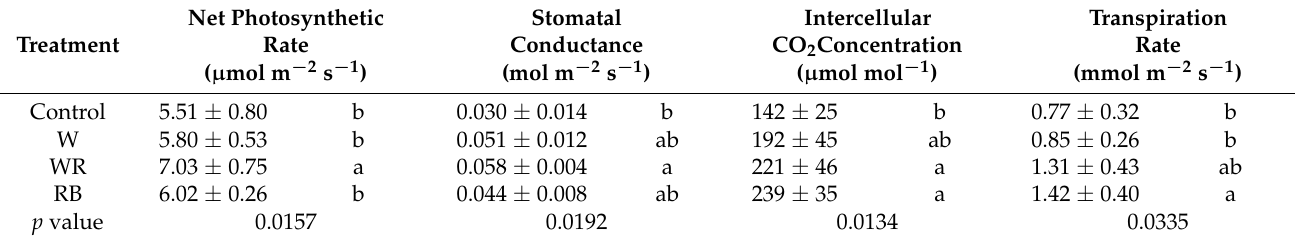
Table 3. The photosynthetic characteristics of greenhouse-grown tomato seedlings grown under supplementary white LEDs, white plus red LEDs, and red plus blue LEDs, respectively, and tomato seedlings grown under sunlight only were regarded as the control.